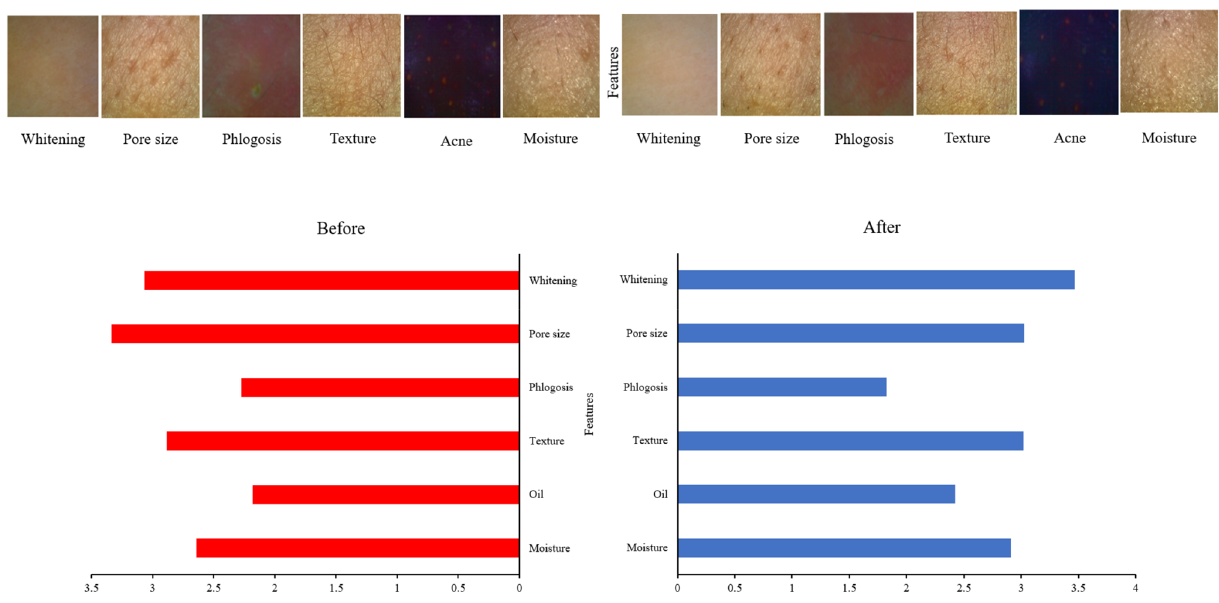
Figure 9. The whitening effect, pore size, phlogosis, texture, oil, and moisture level of skin before and after application of cactus